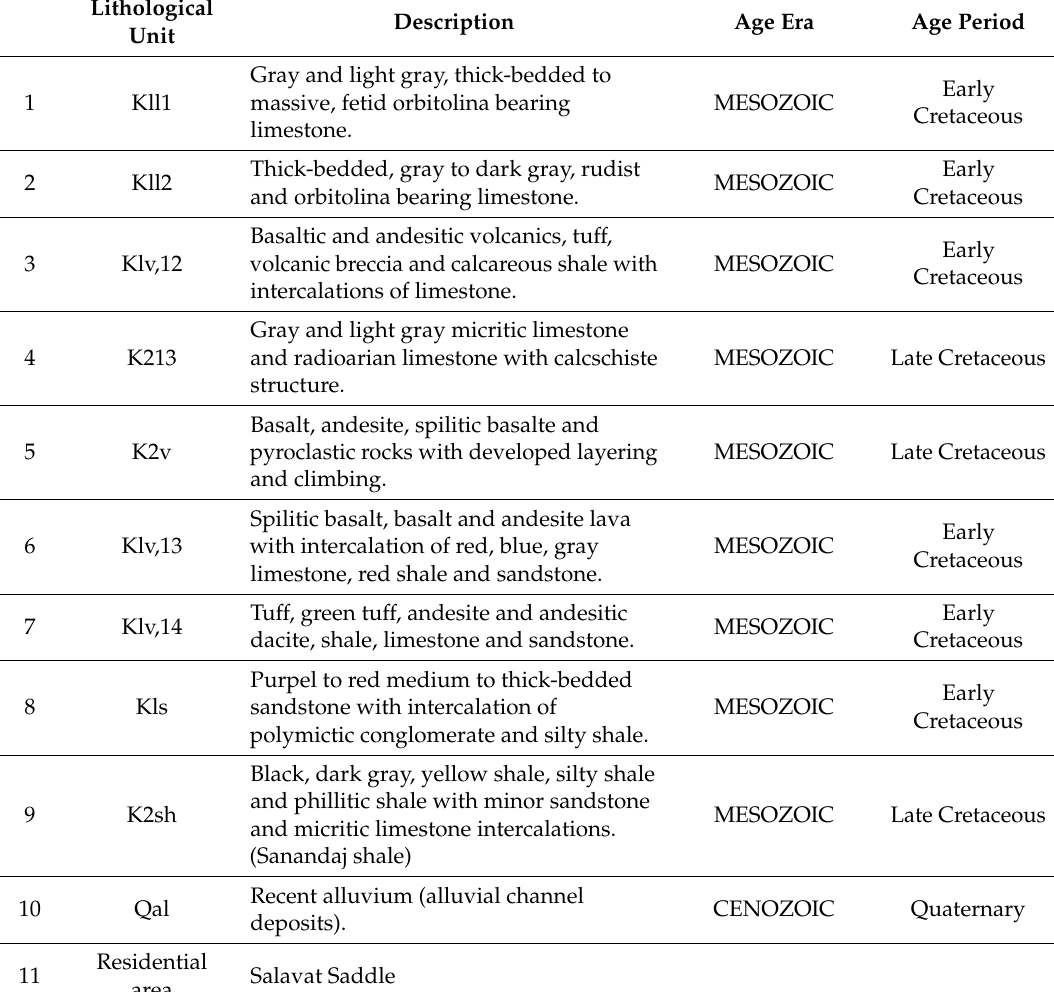
Table 1. Lithological units and its description of the study